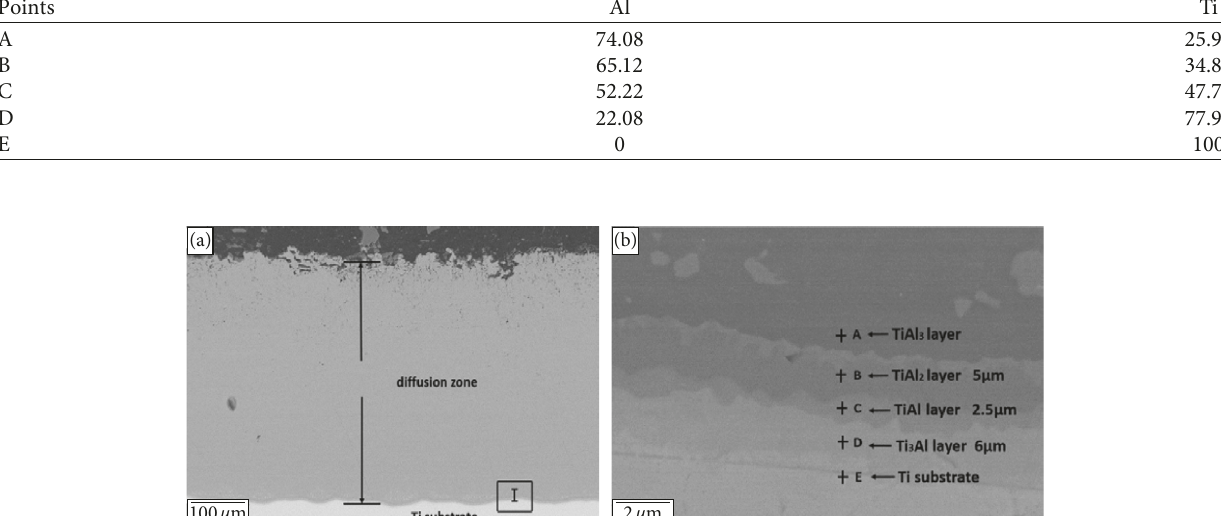
Table 4: The chemical composition (at.%) in different points, as marked in Figure 7(b). Points Al